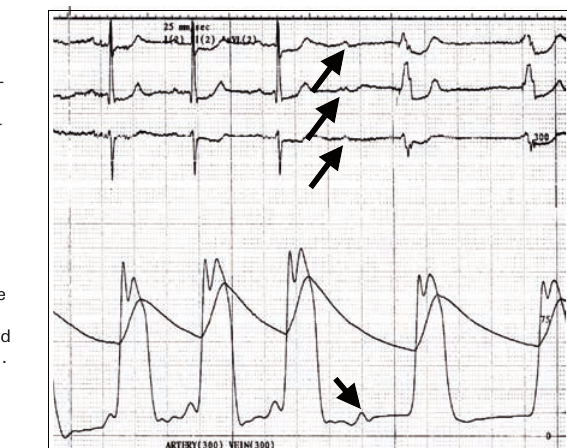
Pressure recording in a patient with severe hypertrophic car- diomyopathy before and after alcohol ab- lation. Shown are eCG recordings of 3 standard leads as well as simultaneous measurements of lV and aortic pressures. There is a large gra- dient of approxi- mately 100 mm Hg (post-extrasystolic 170 mm Hg) before but none after abla- tion.